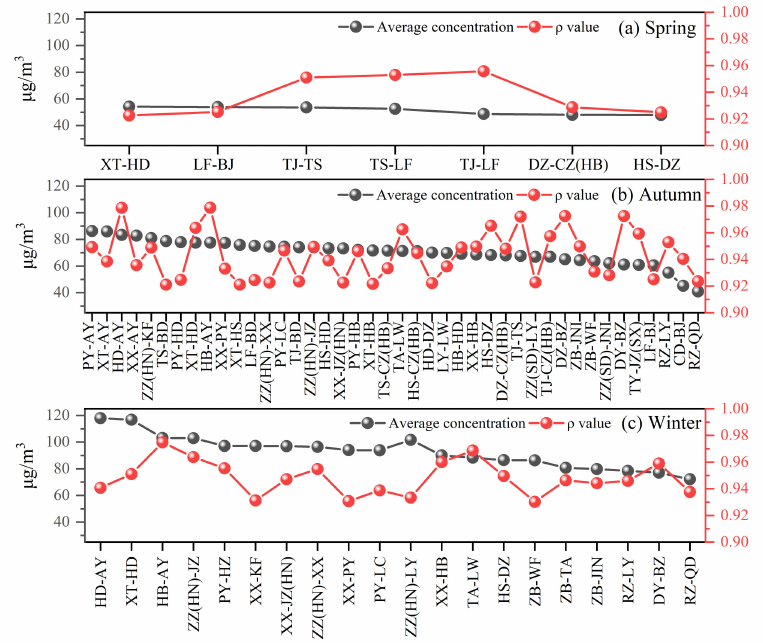
Figure 8. The city-clusters with their average PM 2.5 concentrations and ρ values for the first level in seasons ( a ): Spring, ( b ): Autumn, ( c ): Winter.